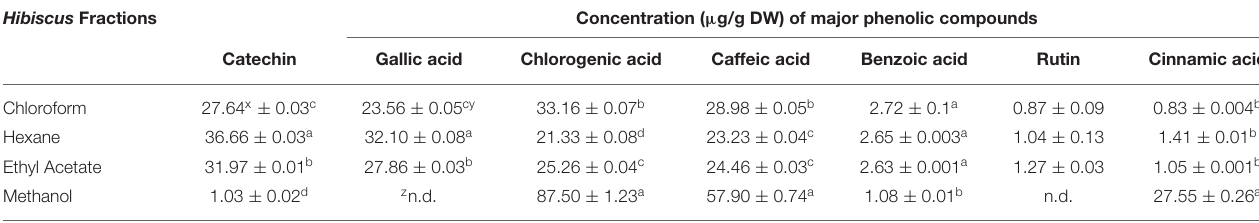
x ± Standard Error. y Different lowercase letters in each column represent statistically significant differences in each phenolic compound (separately for each column) between different organic solvent extracted fractions of Roselle calyces at 95% (p ≤ 0.05) probability level. z n.d. Not